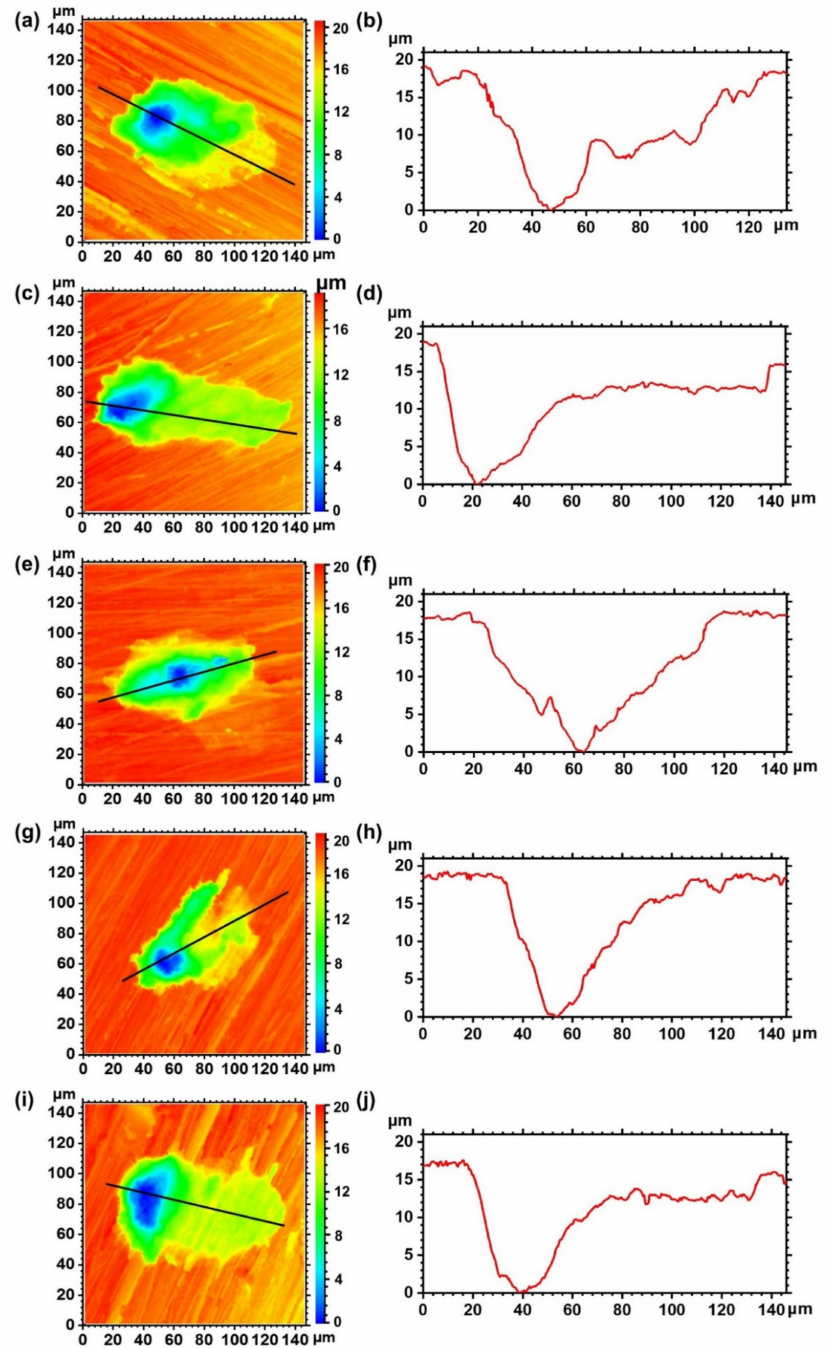
Figure 12. 2D projection images of the deepest corrosion pits on the samples in ( a ) upstream surface, ( c ) incident flow surface, ( e ) top surface, ( g ) backflow surface, and ( i ) downstream surface of the WRH after removing corrosion products. Images of ( b ), ( d ), ( f ), ( h ), and ( j ) are the profiles of the pits along the line crossing the pits in images ( a ), ( c ), ( e ), ( g ), and ( i )